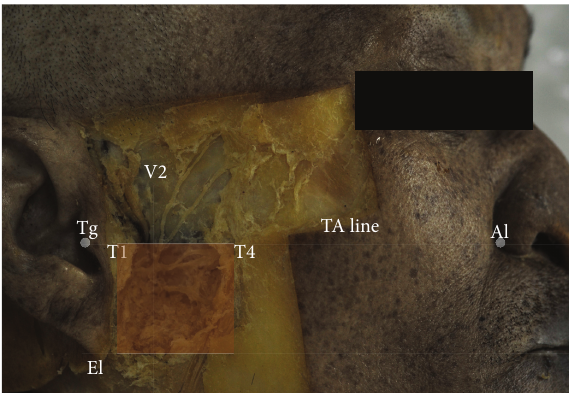
Figure1:Referencelinesandestablishmentofthecondylararea.Tg: tragus; Al: ala of nose; El: lowermost point of earlobe; TA line: the line travelling between Tg and Al; V2: the line 2 cm anterior to the Tg and perpendicular to the TA line; T1: the point 1cm anterior to the Tg on the TA line; T4: the point 4 cm anterior to the Tg on the TA